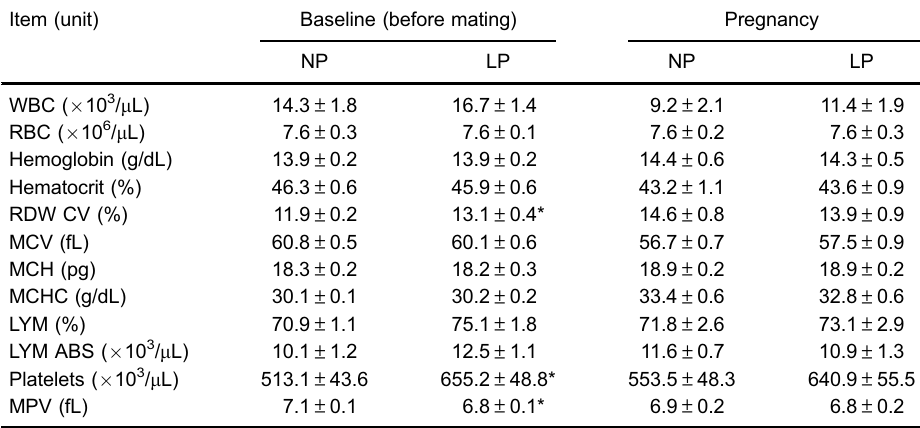
Table 3. Hematological parameters of female rats subjected to a normal- (NP group, 17% protein) or low-protein diet (LP group, 8% protein) during